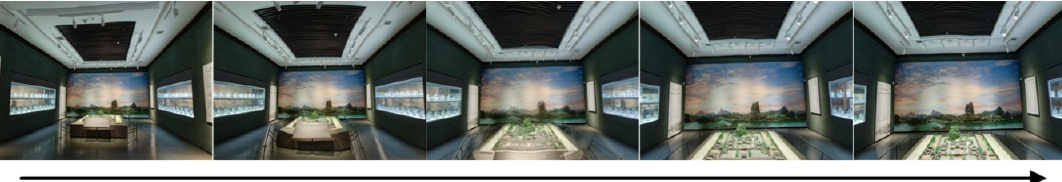
Figure 7. Visual performance of the 360 ◦ panoramic walkthrough system with smooth transitions Figure 7. Visual performance of the 360° panoramic walkthrough system with smooth transitions between adjacent viewpoints. The panorama scene transitions from the current site to the next with the between adjacent viewpoints. The panorama scene transitions from the current site to the next with Figure 7. Visual performance of the 360° panoramic walkthrough system with smooth transitions process ranging from 0.0 to 1.0. Figure 7. Visual performance of the 360° panoramic walkthrough system with smooth transitions Figure 7. Visual performance of the 360° panoramic walkthrough system with smooth transitions Figure 7. Visual performance of the 360° panoramic walkthrough system with smooth transitions the process ranging from 0.0 to 1.0. between adjacent viewpoints. The panorama scene transitions from the current site to the next with between adjacent viewpoints. The panorama scene transitions from the current site to the next with between adjacent viewpoints. The panorama scene transitions from the current site to the next with between adjacent viewpoints. The panorama scene transitions from the current site to the next with Figure 7. Visual performance of the 360° panoramic walkthrough system with smooth transitions Figure 7. Visual performance of the 360° panoramic walkthrough system with smooth transitions the process ranging from 0.0 to 1.0. the process ranging from 0.0 to 1.0. the process ranging from 0.0 to 1.0. the process ranging from 0.0 to 1.0. the process ranging from 0.0 to 1.0. between adjacent viewpoints. The panorama scene transitions from the current site to the next with between adjacent viewpoints. The panorama scene transitions from the current site to the next with the process ranging from 0.0 to 1.0. the process ranging from 0.0 to 1.0.